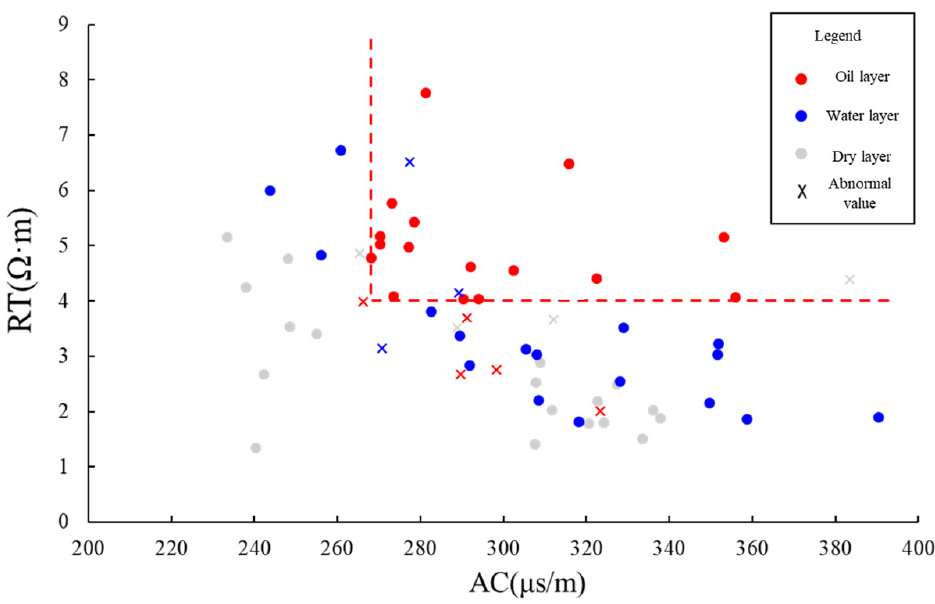
Figure 6. Confusion matrix of oil and water classification of training samples. Green means accu- rate prediction, pink means wrong prediction.